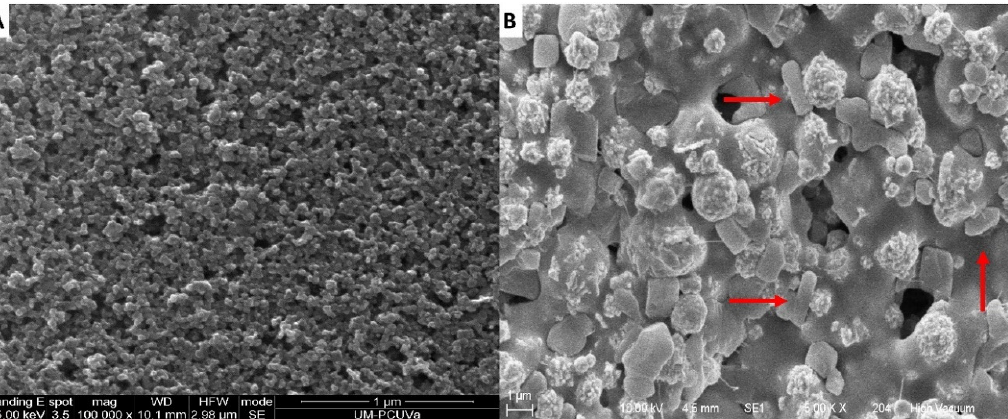
Figure 6. ( A ) SEM micrograph of the unmodified gold electrode surface (DropSens 220BT). ( B ) SEM micrograph of the surface of the gold electrode modified with Salmonella spp. (10 5 CFU mL − 1 ).